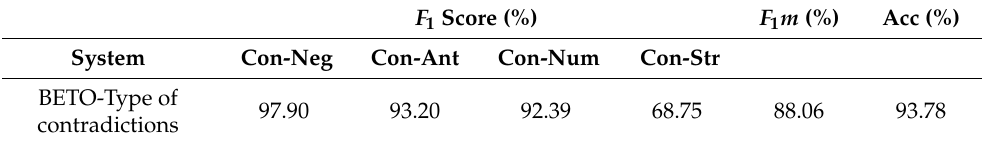
Table 6. Results obtained from Experiment 4: Detecting each specific type of contradiction